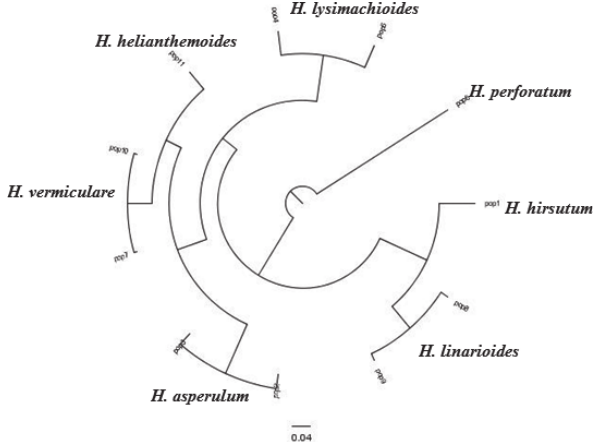
Figure 1. Morphological characters analysis of Hypericum species by UPGMA tree.